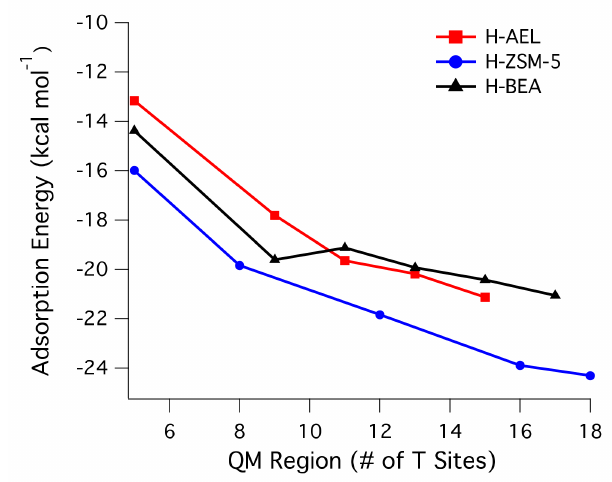
Figure 2. Calculated adsorption energies as a function of the size of the QM region using ONIOM (M06-2X /